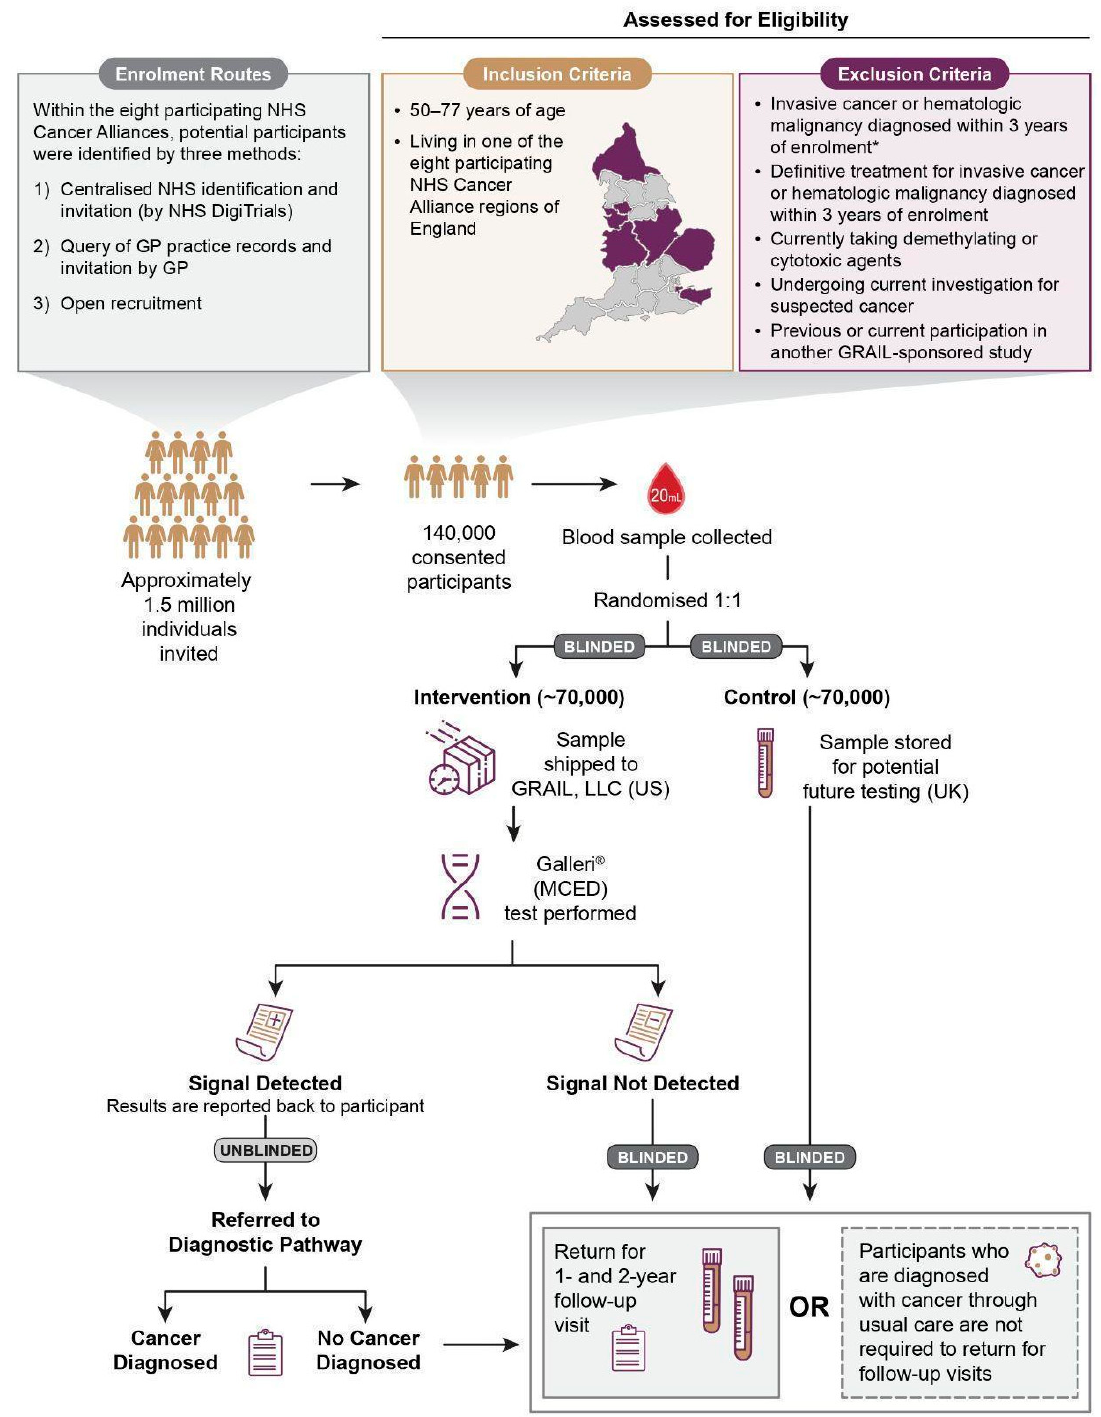
Figure 1. An overview of the NHS-Galleri trial. GP, general practitioner; MCED, multi-cancer early detection; NHS, National Health Service *Individuals with non-melanoma skin cancer and individuals with prostate cancer whose only treatment is active surveillance are not excluded.